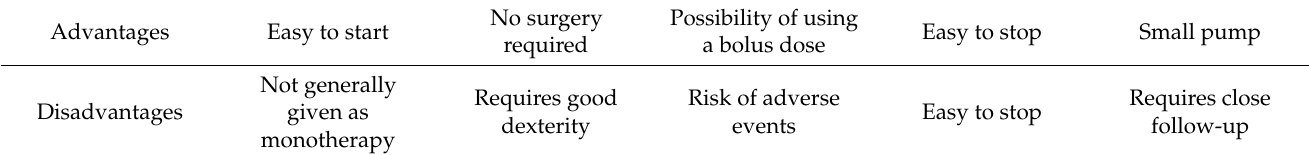
Table 1. Advantages and disadvantages of SCAI as a treatment option for advanced PD.